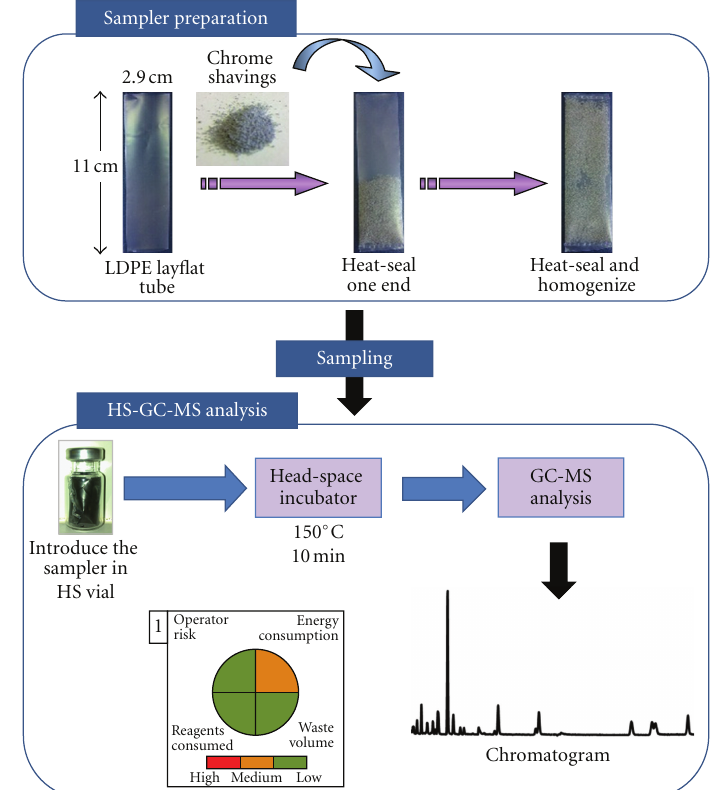
Figure 1: Chrome shavings based passive sampler preparation and HS-GC-MS analytical method employed for the determination of VOCs. Inset 1 :pictogram describing the green parameters of the employed method.